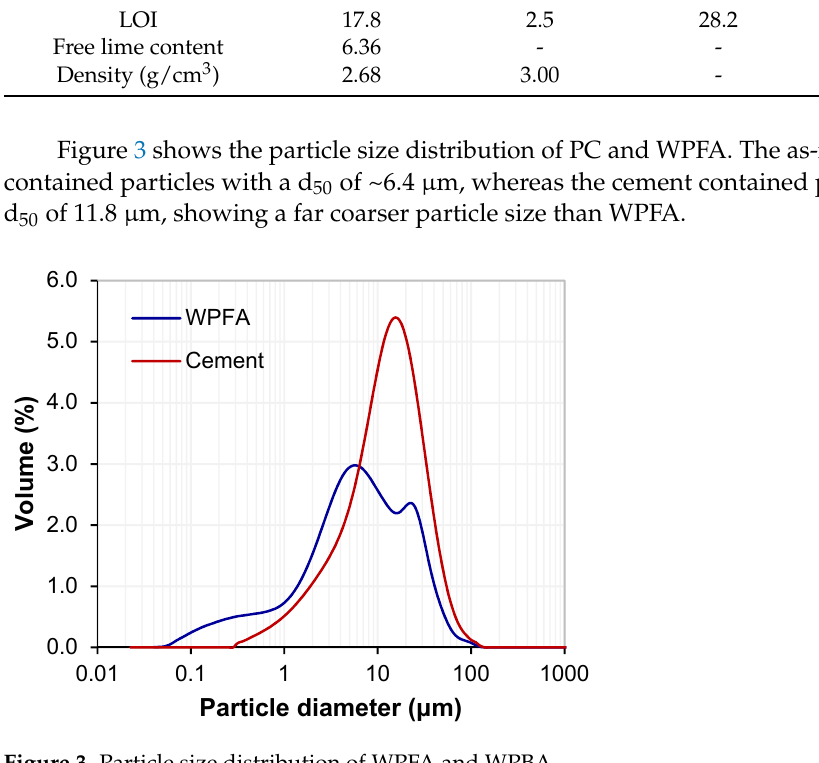
Figure 3. Particle size distribution of WPFA and WPBA.